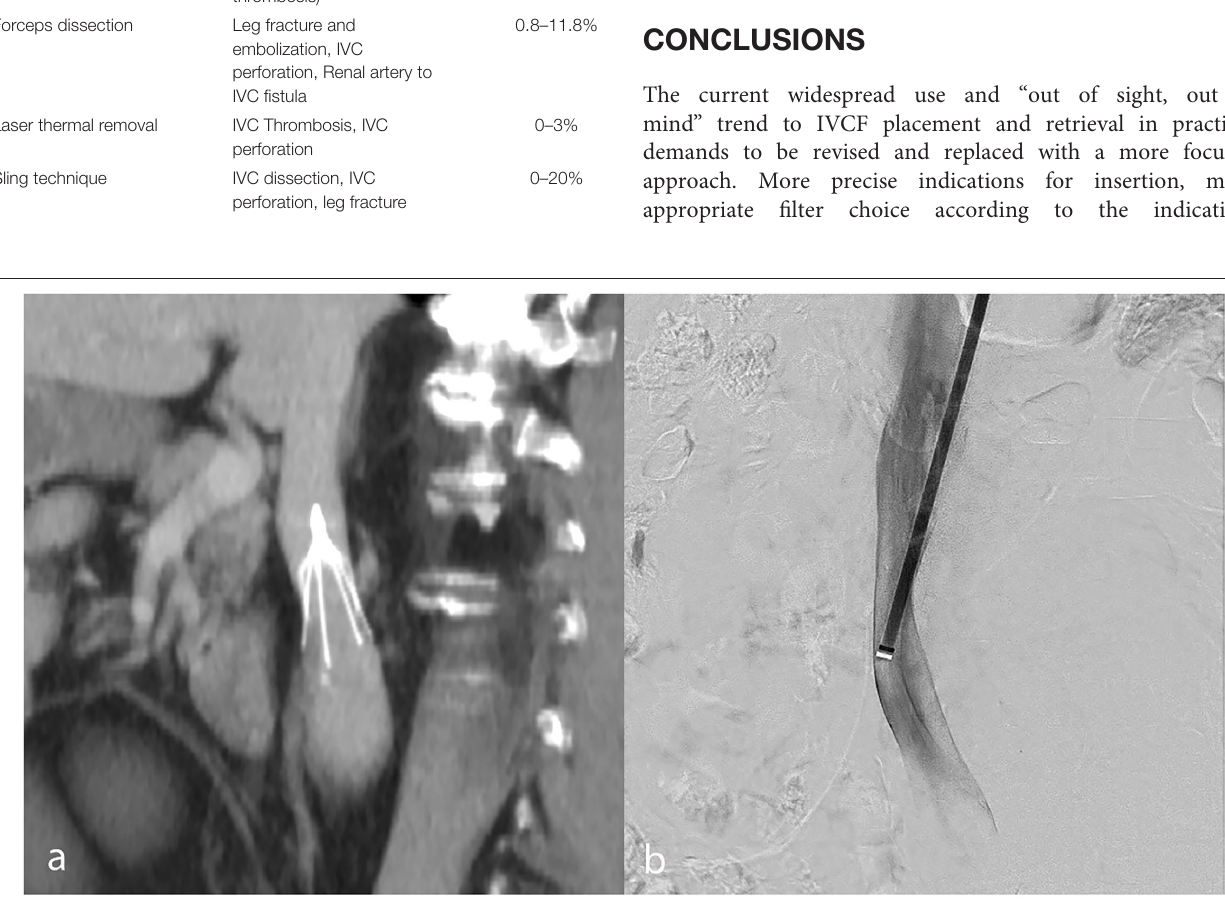
FIGURE 4 | IVC stenosis due to IVCF use, shown in a patient on coronally reformatted pre-retrieval CT venography (a) . Post-retrieval subtracted catheter-directed cavography (b) confirms a persistent focal IVC stenosis at the former filter site.